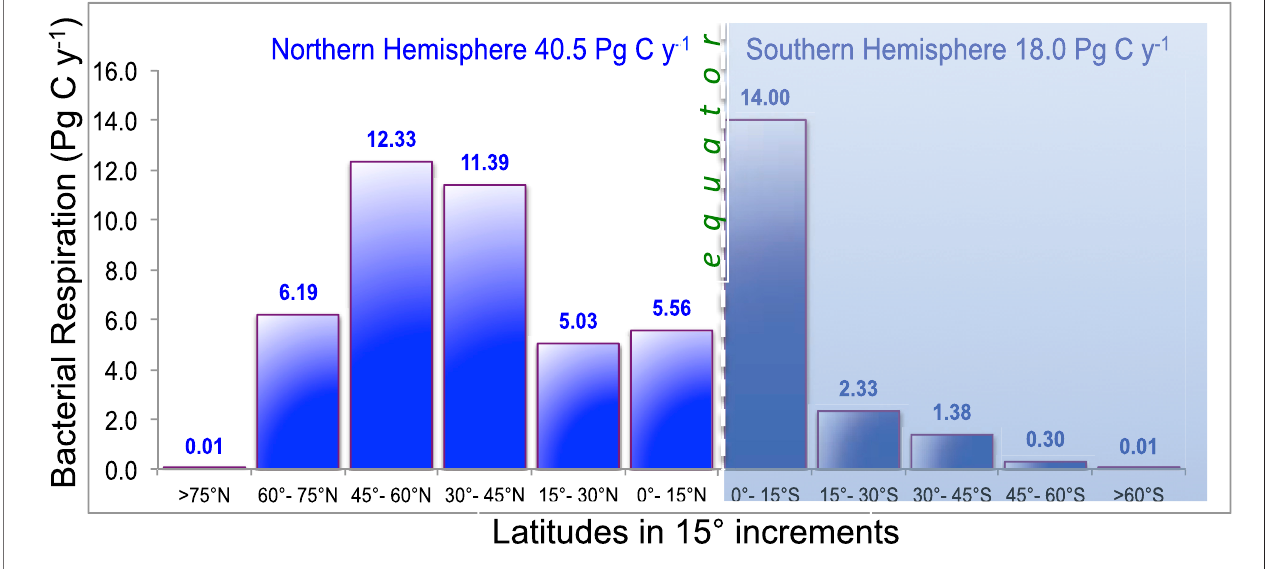
FIGURE 5 | From 1991 to 2011 the annual rates of carbon respired from each 15 ° latitude bandwidth is shown for the freshwater top 10 m. The Northern Hemisphere (not shaded) is emitting CO 2 at twice the rate of the Southern Hemispheres (shaded area); 2.25 : 1, respectively.